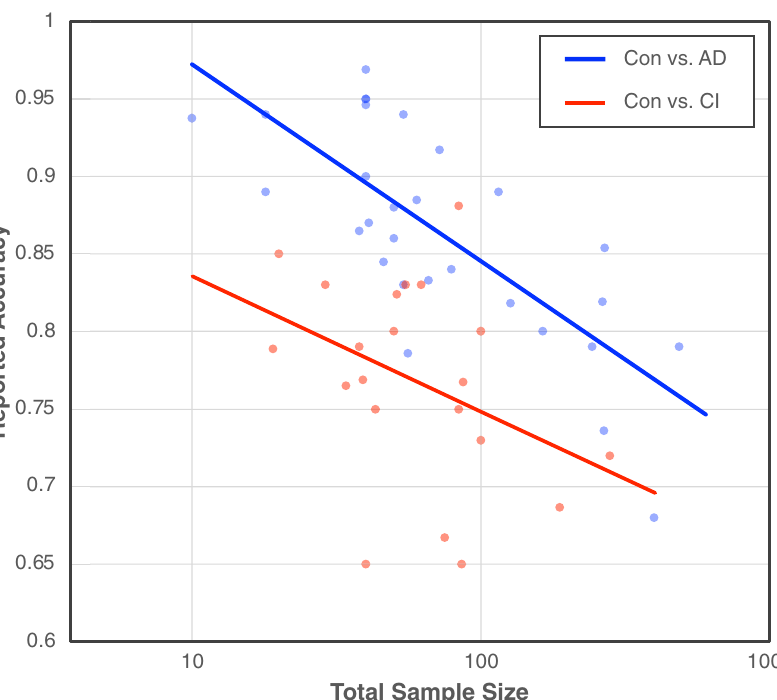
Fig. 4 The reported accuracy vs. total sample size for 51 classi fi ers from the meta-analyses in refs. 7,8 . This analysis considers two types of models: (1) speech-based models for classifying between a control group and patients with a diagnosis of Alzheimer ’ s disease (Con vs. AD; blue plot) and (2) speech-based models for classifying between a control group and patients with other forms of cognitive impairment (Con vs. CI; red plot). The total sample size is the sum of the number of subjects in the control group and the clinical group. The y-axis is in linear scale and the x-axis is in log scale as it spans multiple orders of